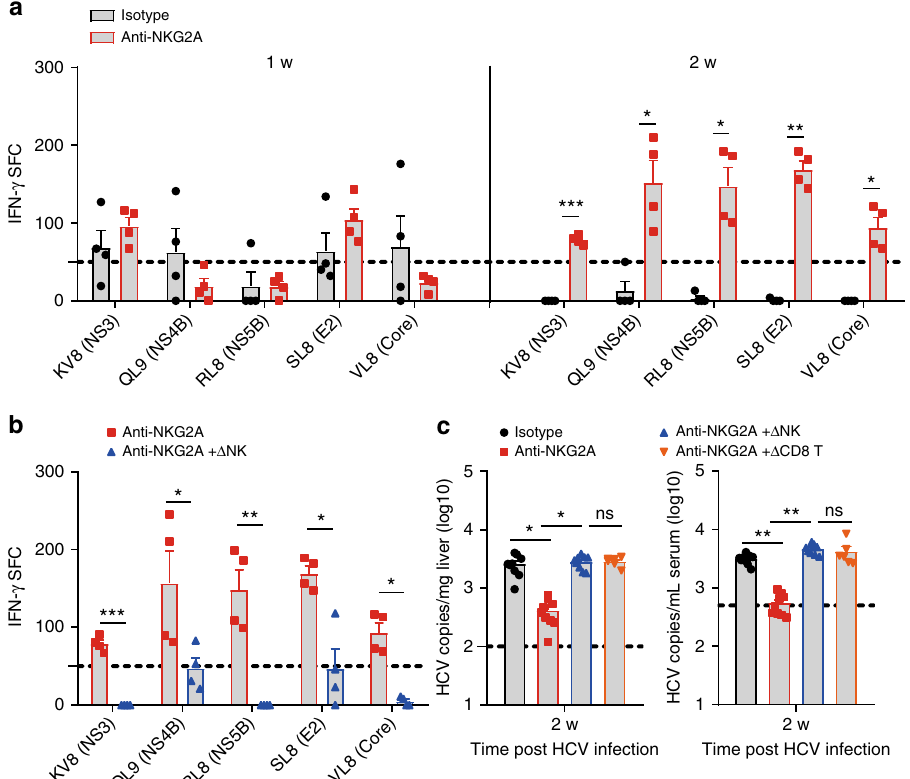
Fig. 4 NK cells instructed T cells in HCV persistence. a Mice were treated as in Fig. 3d. ELISpot assays using splenocytes and the indicated epitope peptides. C/O Tg mice were i.p. pre-treated with mock IgG ( n = 9) or b anti-AGM1 (20 μ g/3 days, n = 9), c anti-CD8 (100 μ g/3 days, n = 6), together with anti-NKG2A antibody 1 d before HCV inoculation. b HCV-speci fi c CD8 + T cell response by IFN- γ ELISpot and c hepatic and serum HCV RNA copies were measured 2 wpi. Dash lines indicated limits of detection of related assays (qPCR, 500 copies/mL serum or 100 copies/mg liver; ELISpot, 50 spots/4 × 10 5 splenocytes). Data were mean ± SD, Student t- test. * P < 0.05; ** P < 0.01; *** P < 0.001. ns Not signi fi cant. Source data are provided as a Source Data fi